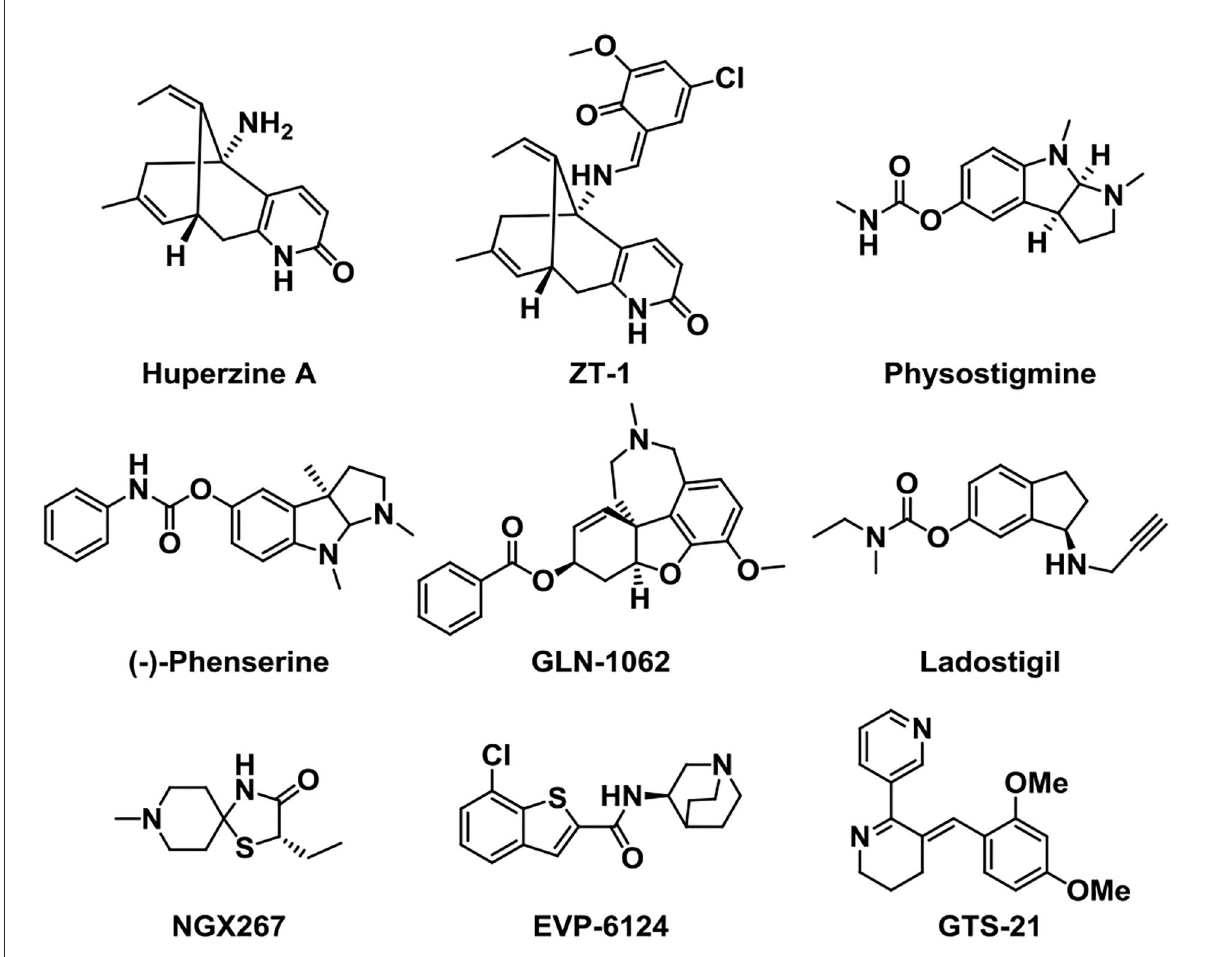
FIGURE3 Structures of cholinergic inhibitors in the study.